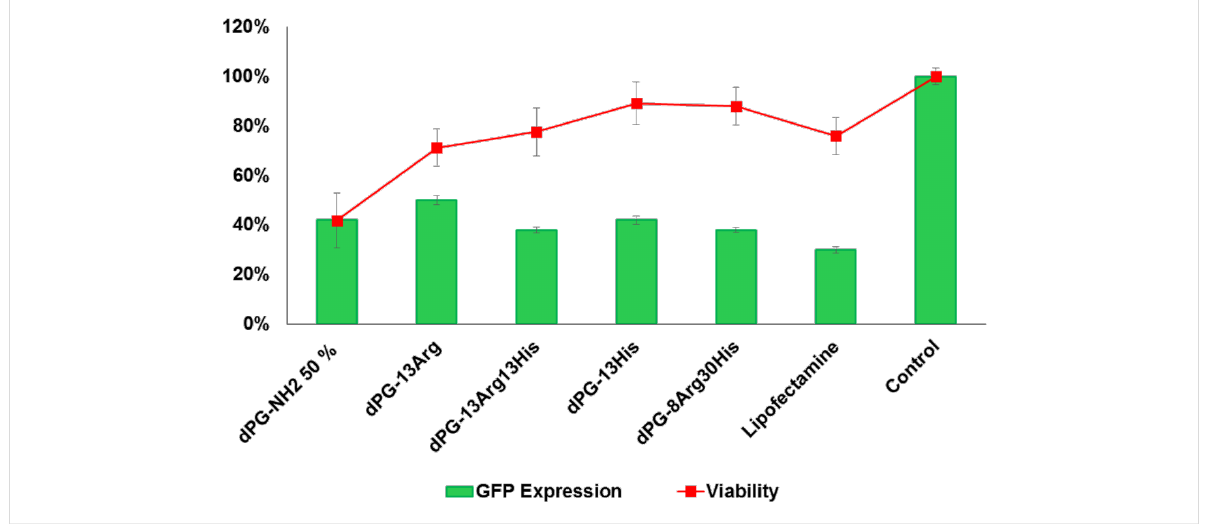
Figure 5: Summary of transfection results versus viability of AAdPGs with various Arg and His composition ratio at N/P ratio 30.